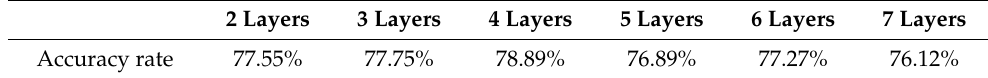
Table 4. Model accuracy in relation to the number of layers.